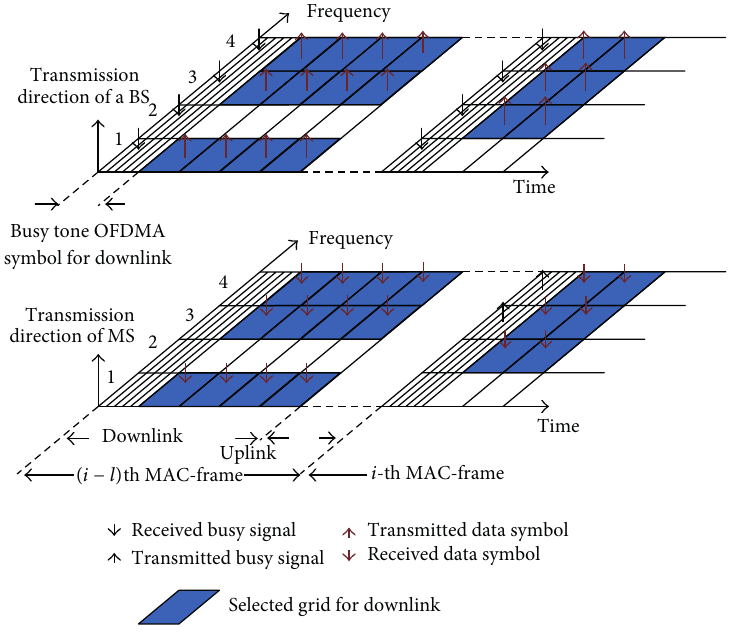
Figure 2: Structure of the MAC frame for DSA